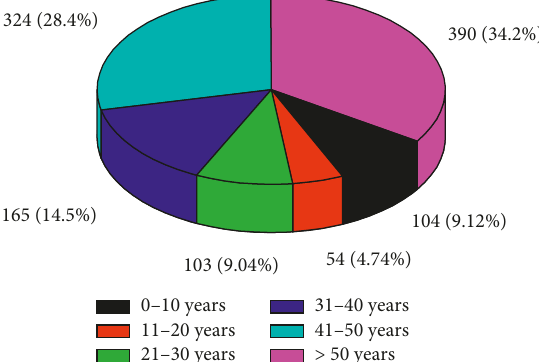
Figure 1: Age distribution of the patients ( N � 1140) whose medications and prescriptions were involved in the study at the Edna Adan University Hospital, between August 28, 2019,